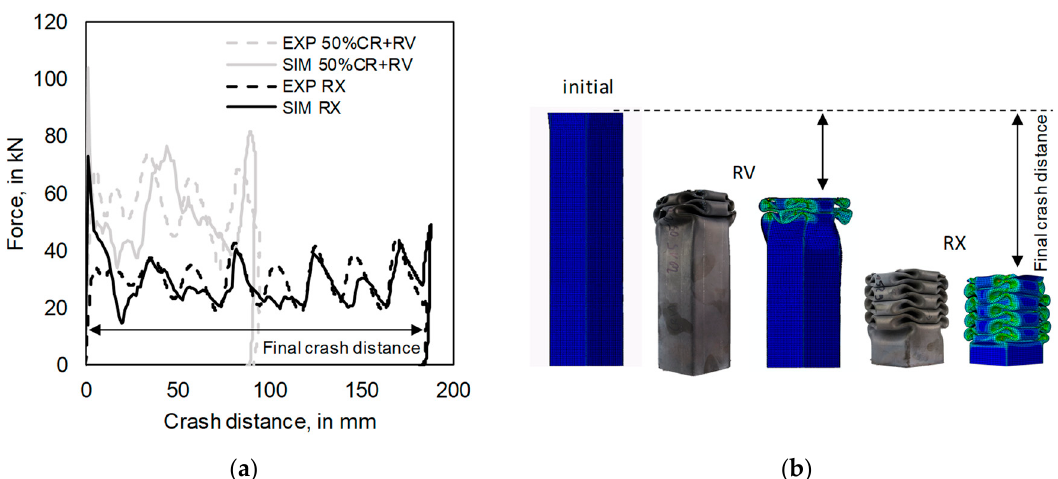
Figure 5. ( a ) Experimental and simulated force–distance curves from drop tower tests with sheet thickness t = 1 mm of the RX and 50% CR + RV conditions; ( b ) Geometries of the crash boxes before (initial) and after simulated and experimental drop tower tests of the RX and 50% CR + RV conditions.